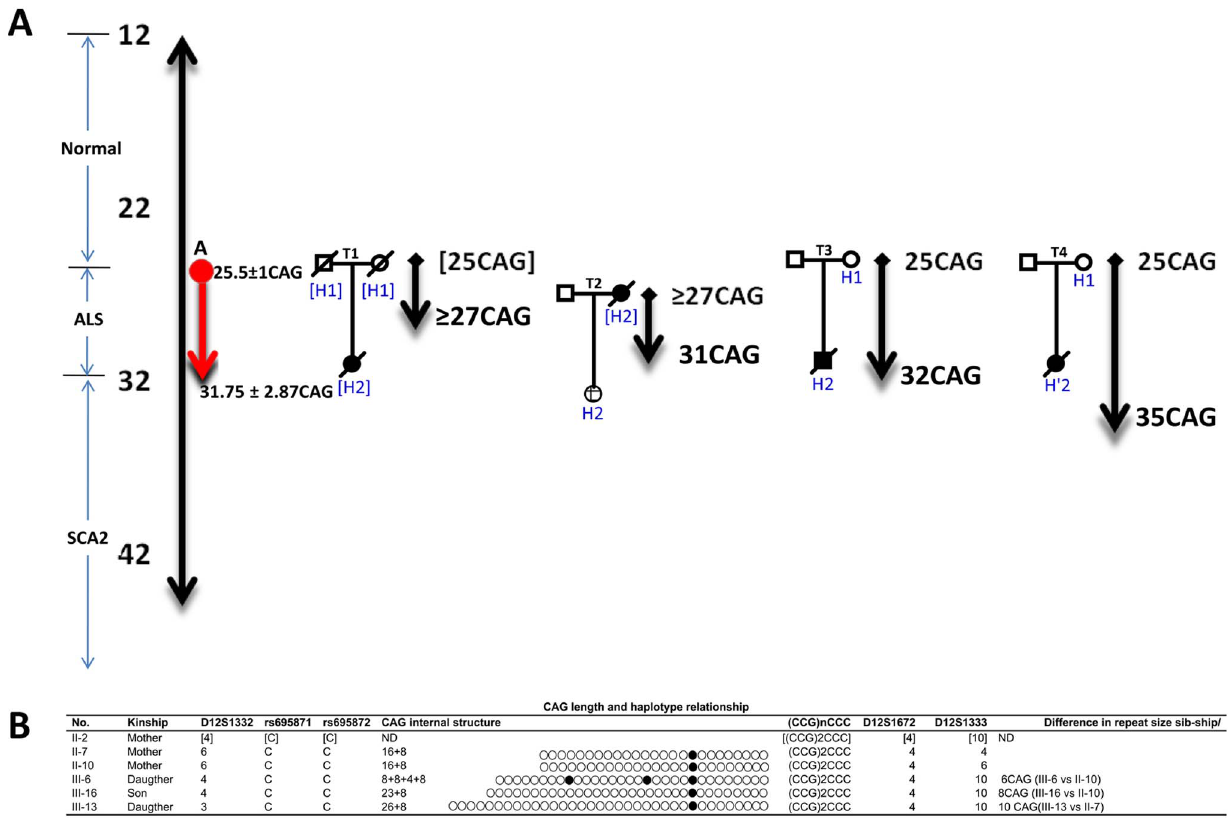
Figure 4. CAG repeat instabilities and denovoATXN2 mutations associated with ALS in relationship with the haplotype. A) Schematic presentation of the CAG instabilities in four transmissions (T1–T4) of SCA2 (drawn to scale). Haplotypes are indicated as H1, H2, H 9 1and H 9 2 (see explanation in the text). Red (A), represents the average for CAG instabilities in the four transmissions. All transmissions reach either ALS (27–33 CAG) or SCA2 ( $ 34 CAG) thresholds. B) Scheme representing the haplotype and CAG(CCG)2CCC sequence for the individuals involved in the unstable CAG transmissions. Data between brackets is inferred from the segregation analysis. D12S1332, 3: 202 bp, 4: 198 bp, 6: 190 bp, D12S1672, 4: 289 bp, D12S1333, 4: 257 bp, 6: 251 bp, 10: 239